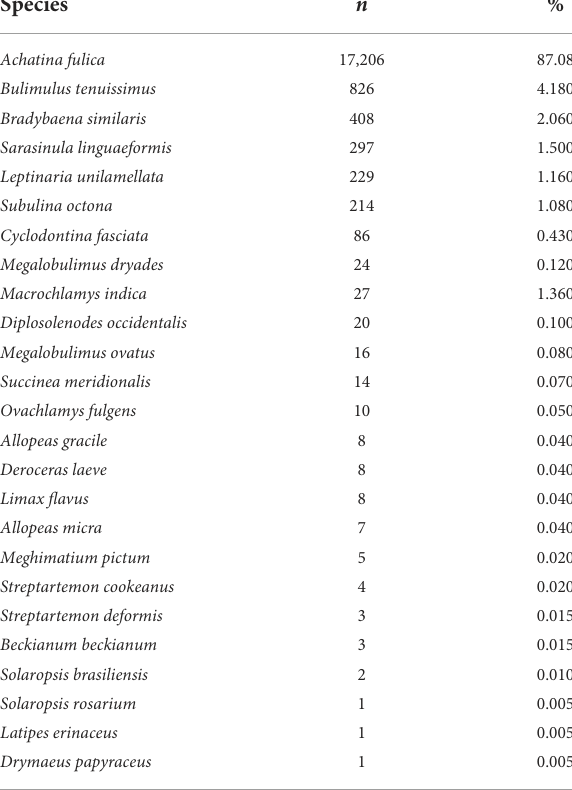
TABLE 1 Taxa received and identified in specific level and their percentage in relation to the total of mollusks received at the LRNEM between 2008 and 2021, including those identified in genera